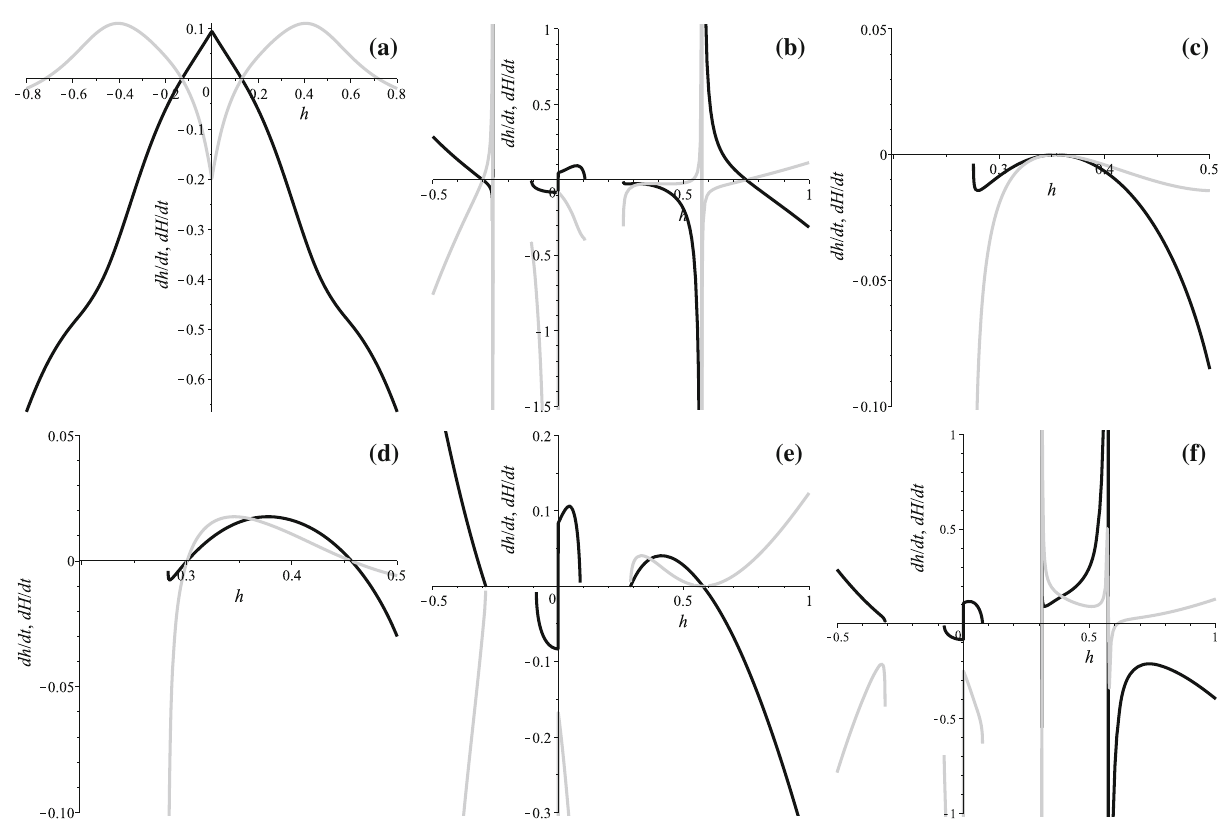
Fig. 4 ˙ h ( h ) ( black ) and ˙ H ( h ) ( gray ) curves for α > 0, (cid:2) > 0 D = 3 (cid:2) -term cases: H 1 on a and H 2 on the remaining: α(cid:2) < 3 / 8 on b , detail of α(cid:2) = 3 / 8 on c , the same detail for 1 / 2 > α(cid:2) > 3 / 8 on d , α(cid:2) = 1 / 2 on e and α(cid:2) > 1 / 2 on f (see the text for more